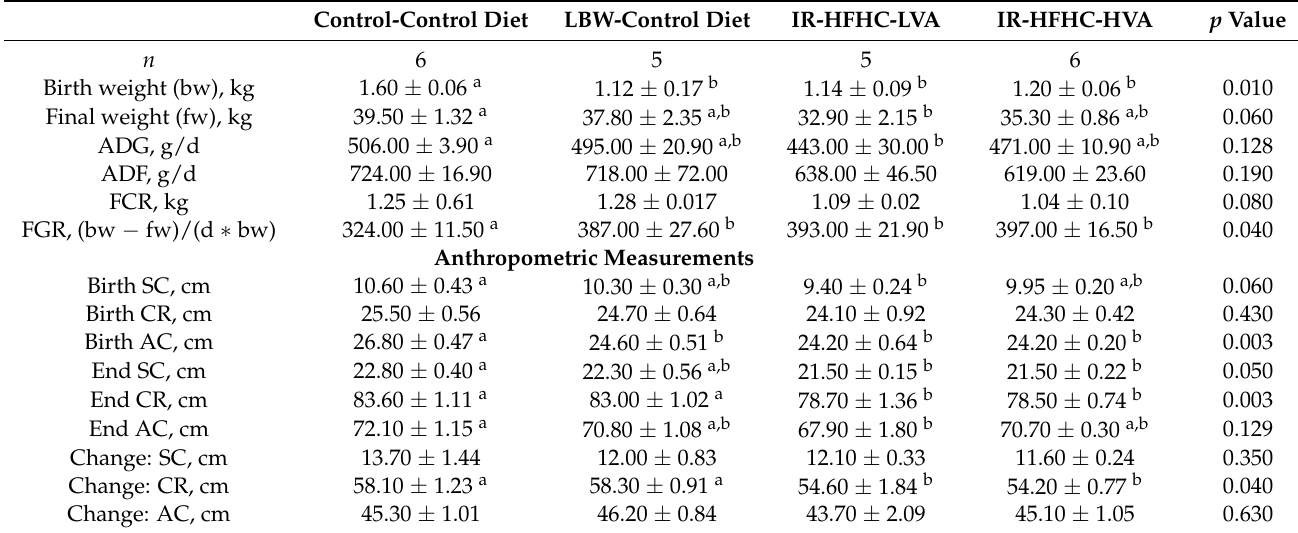
Table 3. Growth, consumption, and anthropometric measurements of control and LBW pigs fed control, HFHC-LVA, and HFHC-HVA diets until 10 weeks of age.